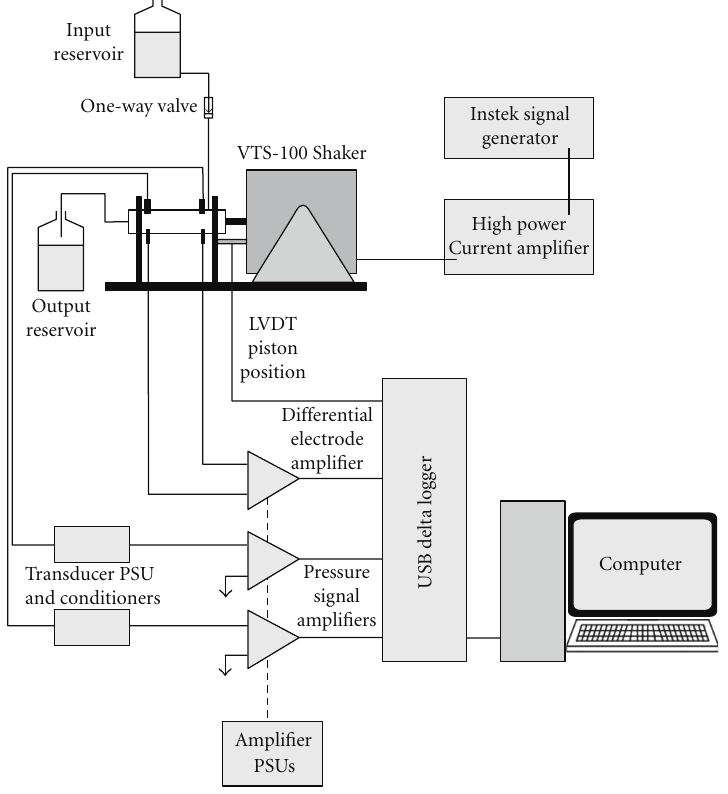
Figure 6: Experimental